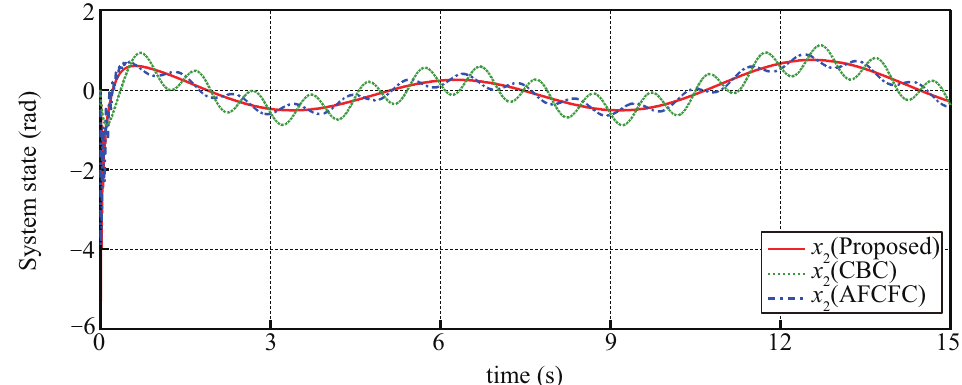
Figure 11. Tracking error e 1 under the three controllers.